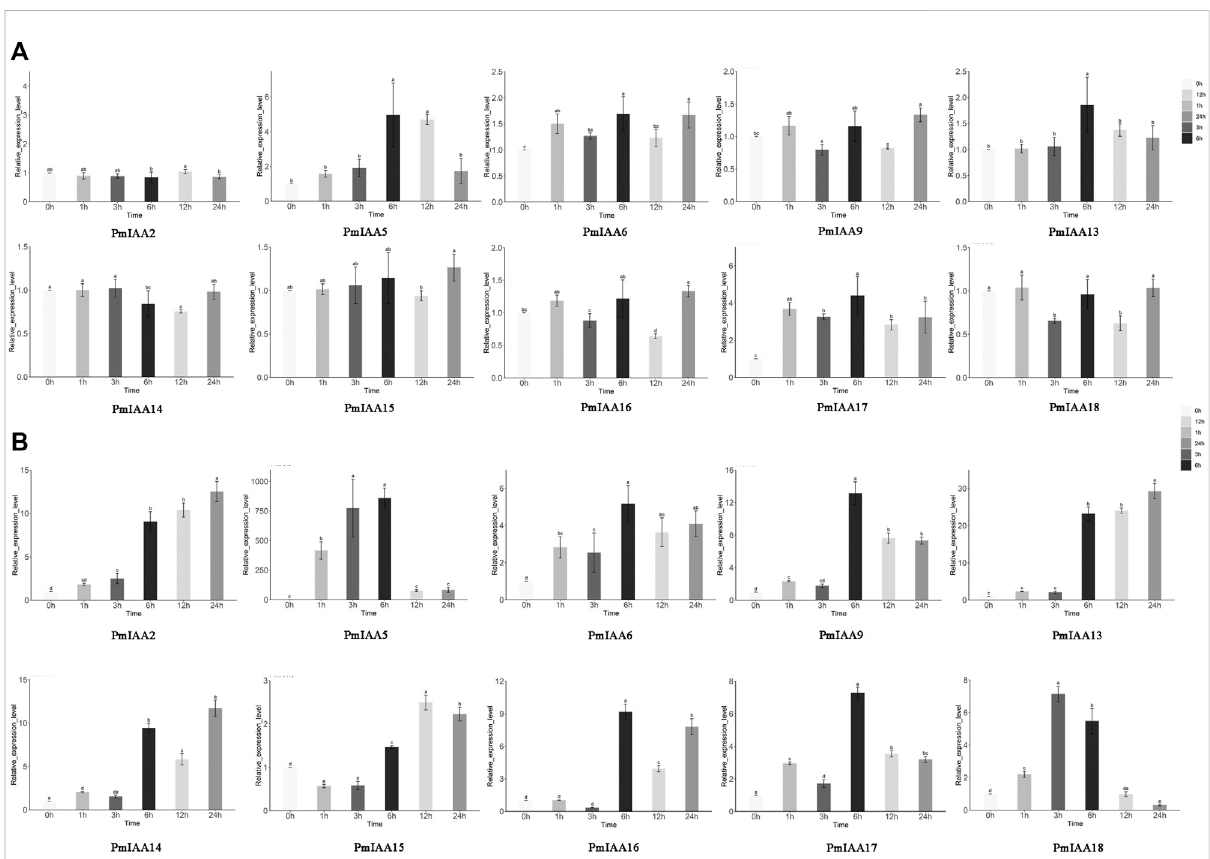
FIGURE 6 Expression pattern analysis of PmIAAs in IAA response (A) The relative gene expression level of PmIAAs after IAA treatment in buds (B) The relative gene expression level of PmIAAs after IAA treatment in stems. The mean ± standard error of three replicates is shown. The letters above the error bars are marked with signi fi cance for expression